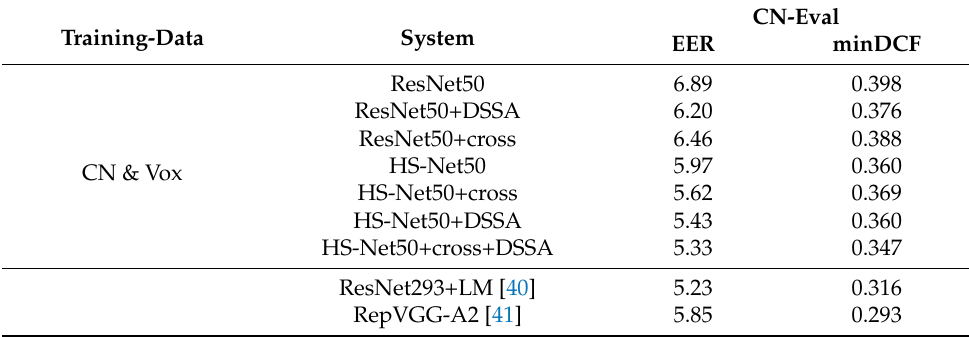
Table 3. Results of three methods and their combination on